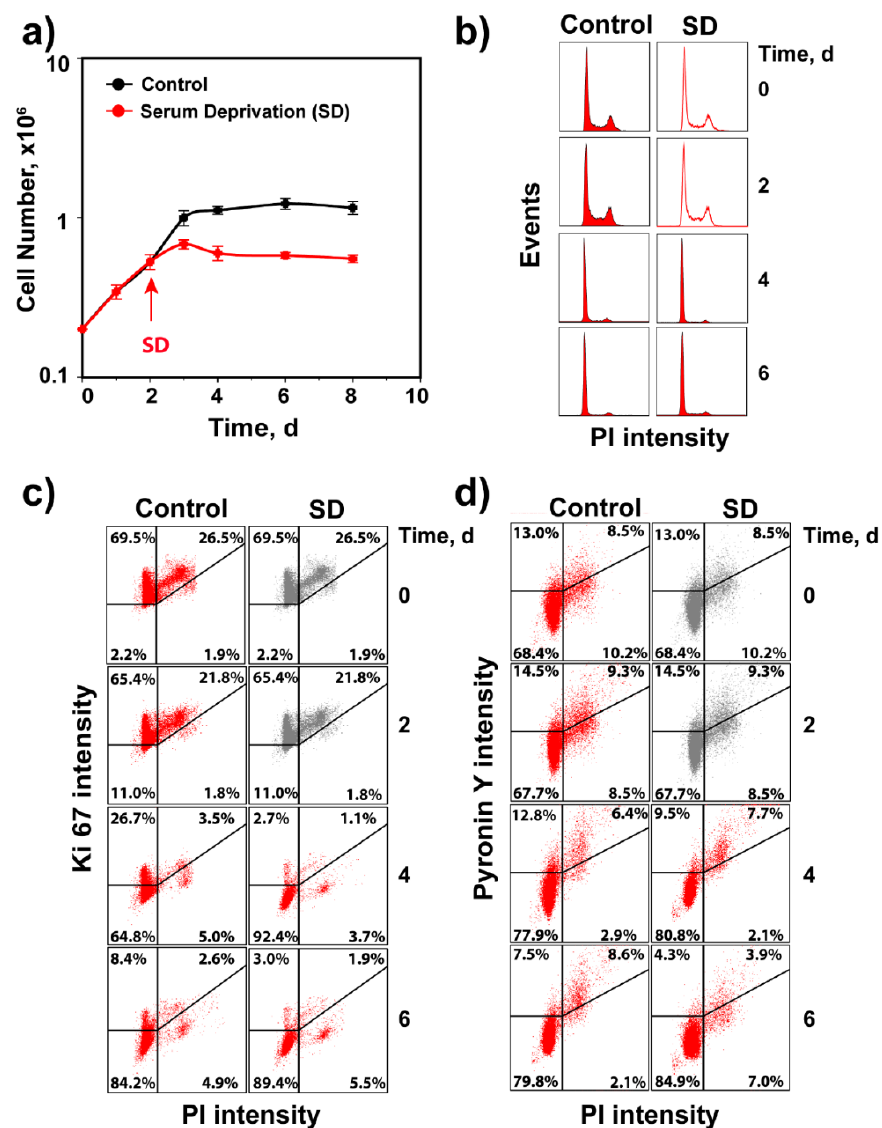
Figure 2. Validation of 82-6 hTert cell cultures for analysis IR-induced G 1 checkpoint in cells irradiated in G 0 . ( a ) Proliferation of 82-6 hTert cells under normal growth conditions, as well as after transfer two days later to serum-free medium (serum deprivation, SD). Plotted is the mean and SE from three independent experiments. ( b ) Cell cycle distribution at the indicated times for cells growing as in A. Note the progressive enrichment in cells with G 1 /G 0 content. ( c ) Characterization of cell cultures in A for Ki67 signal. ( d ) As in C for pyronin Y signal. In ( b – d ), experiments are reproduced 3 times, and one representative is shown.